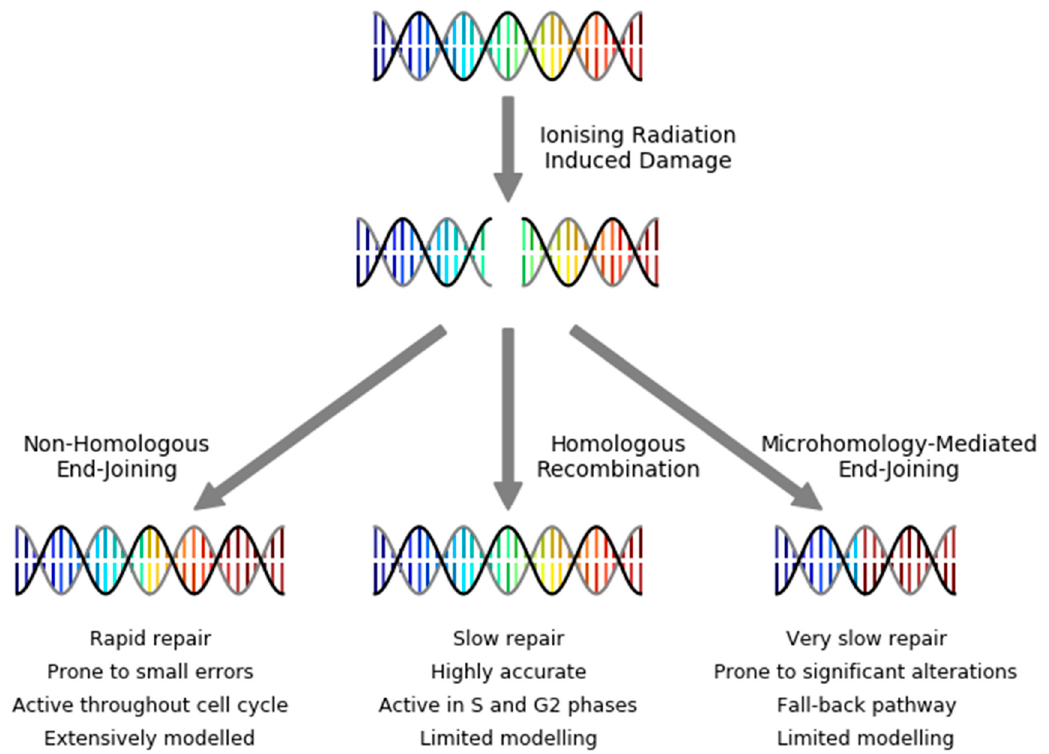
Figure 4. Illustration of double-strand break repair pathways, with DNA sequence progression schematically illustrated by color scale, to highlight sequence alterations. Ionizing radiation induced double strand breaks (top) can be repaired by one of three pathways—Non-Homologous End Joining (NHEJ, left), Homologous Recombination (HR, center), or Microhomology-Mediated End Joining (MMEJ, right). These pathways differ in their efficiency, fidelity, and activity throughout the cell cycle. NHEJ has been the subject of extensive mechanistic modelling in radiotherapy, while relatively few studies have been published of the other pathways.